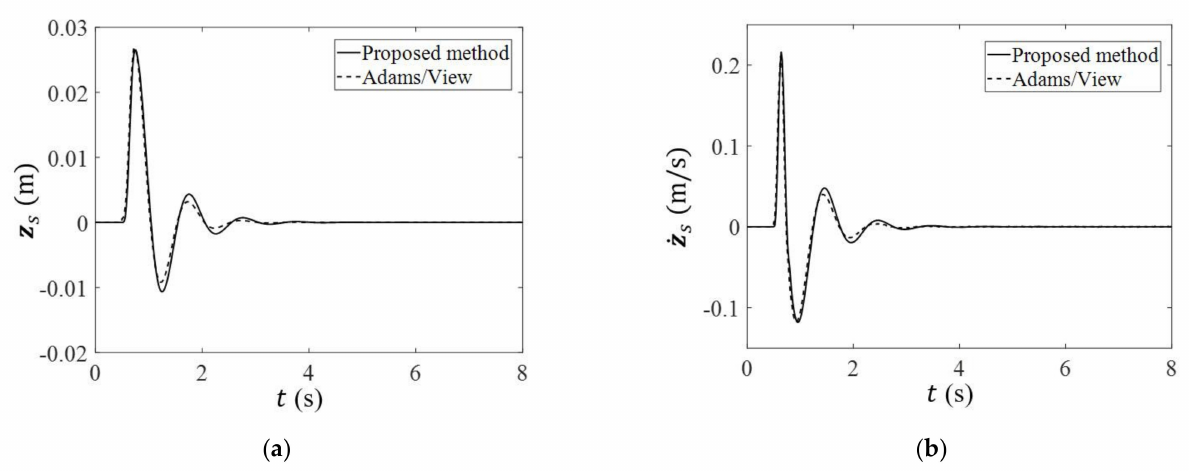
Figure 11. Road disturbance of a single bump.